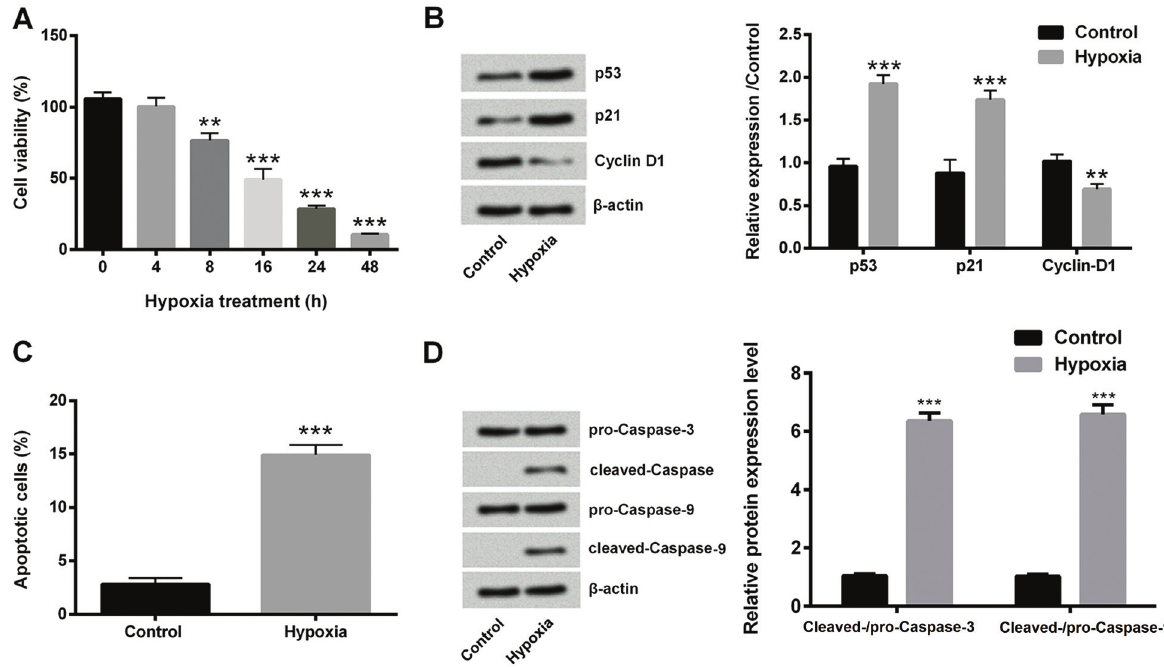
Figure 1. Hypoxia induced injury in H9c2 cells. A , Hypoxia inhibited viability detected by CCK-8 assay. B , Hypoxia (16 h) increased anti- proliferation protein expression and decreased pro-proliferation protein expression examined by western blot. C , Hypoxia (16 h) increased apoptotic cell rate measured by fl ow cytometry. D , Hypoxia (16 h) activated pro-apoptosis protein expression detected by western blot. Data are reported as means ± SD of triplicates. Each experiment was performed three times. **P o 0.01, ***P o 0.001 compared to control (Student ’ s t -test and one-way analysis of